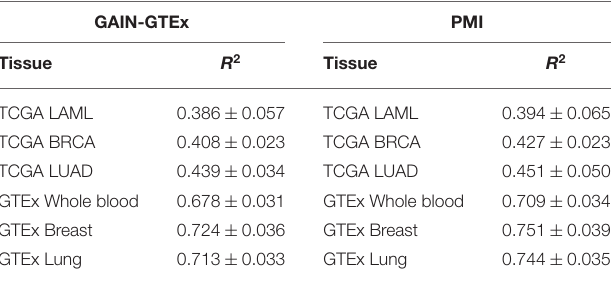
TABLE 3 | Cross-study results for GAIN-GTEx and PMI trained on GTEx (inductive mode). GAIN-GTEx PMI Tissue R 2 Tissue R 2 TCGA LAML 0.386 0.057 TCGA ±